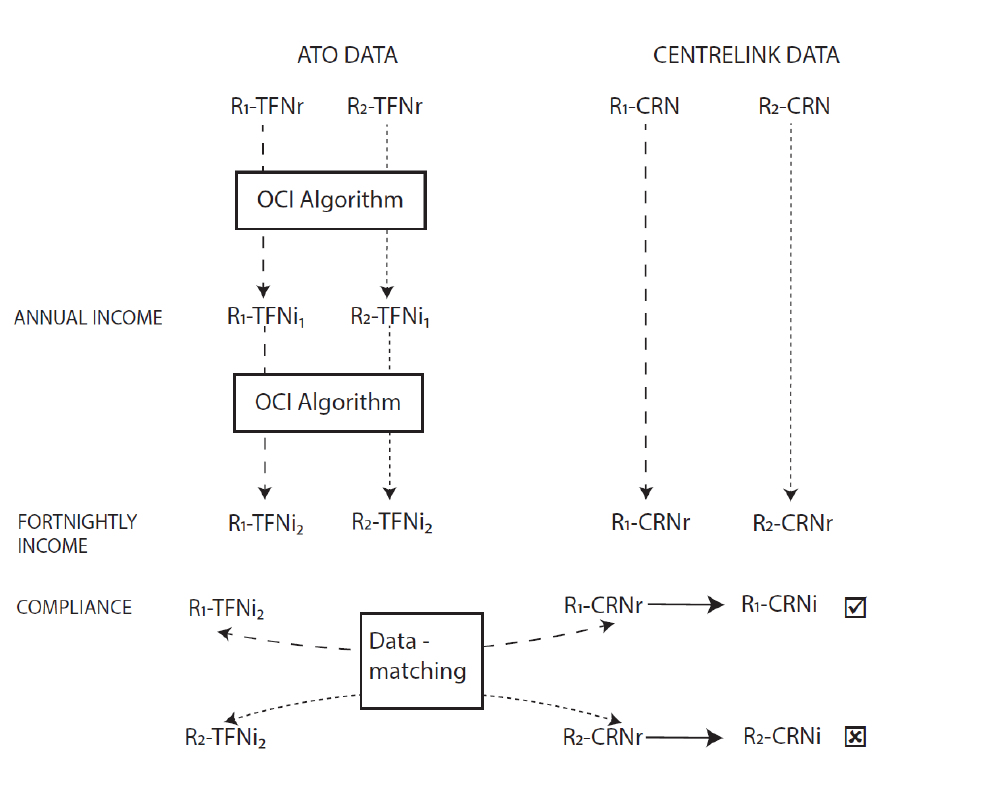
Figure 4. Applying the OCI algorithm to assess Centrelink compliance based on ATO data and recipient declarations of income for a regular low income recipient (R 1 ) and a sporadic low-medium income recipient (R 2